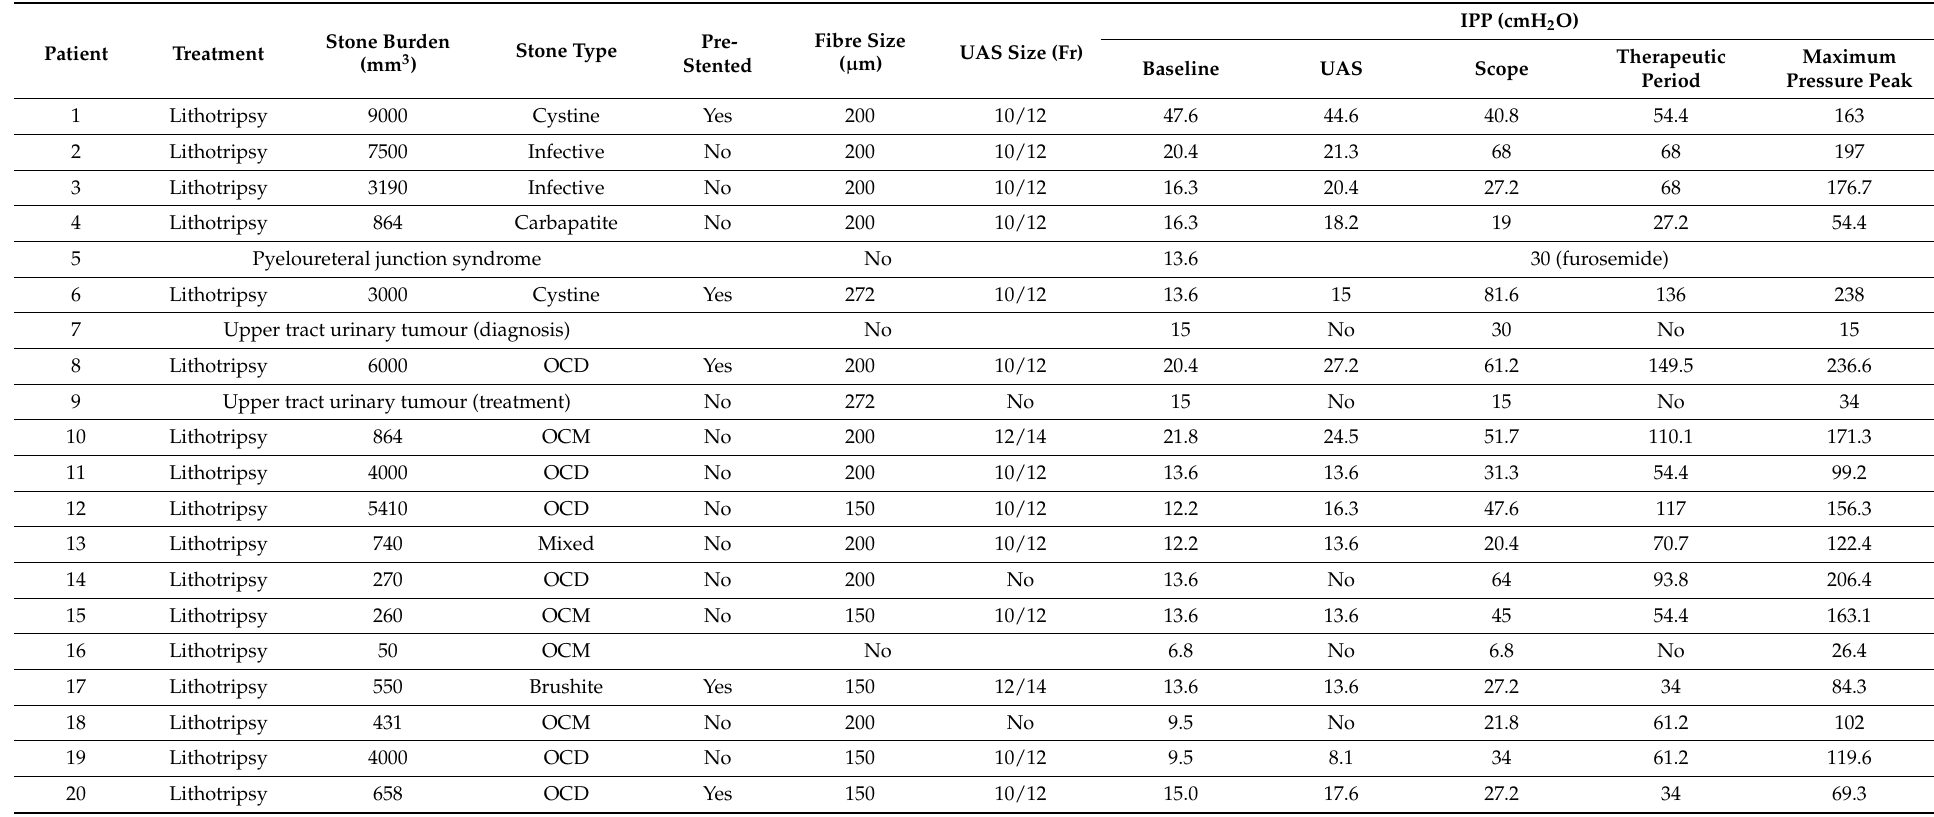
Table 1. Patient characteristics and intrapelvic pressures during flexible